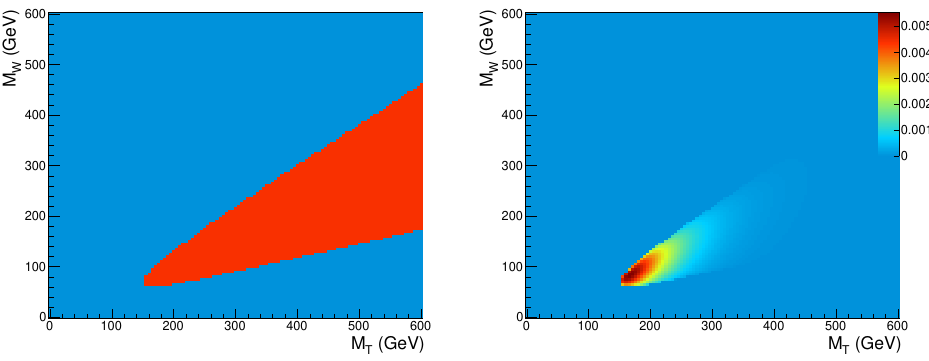
Figure 2 . (Left): solvability for one of the possible solutions of a single top-pair event in the 2-Dimensional mass plane. (Right): solvability weighted with the PDFs and normalized to unit volume for the same solution and